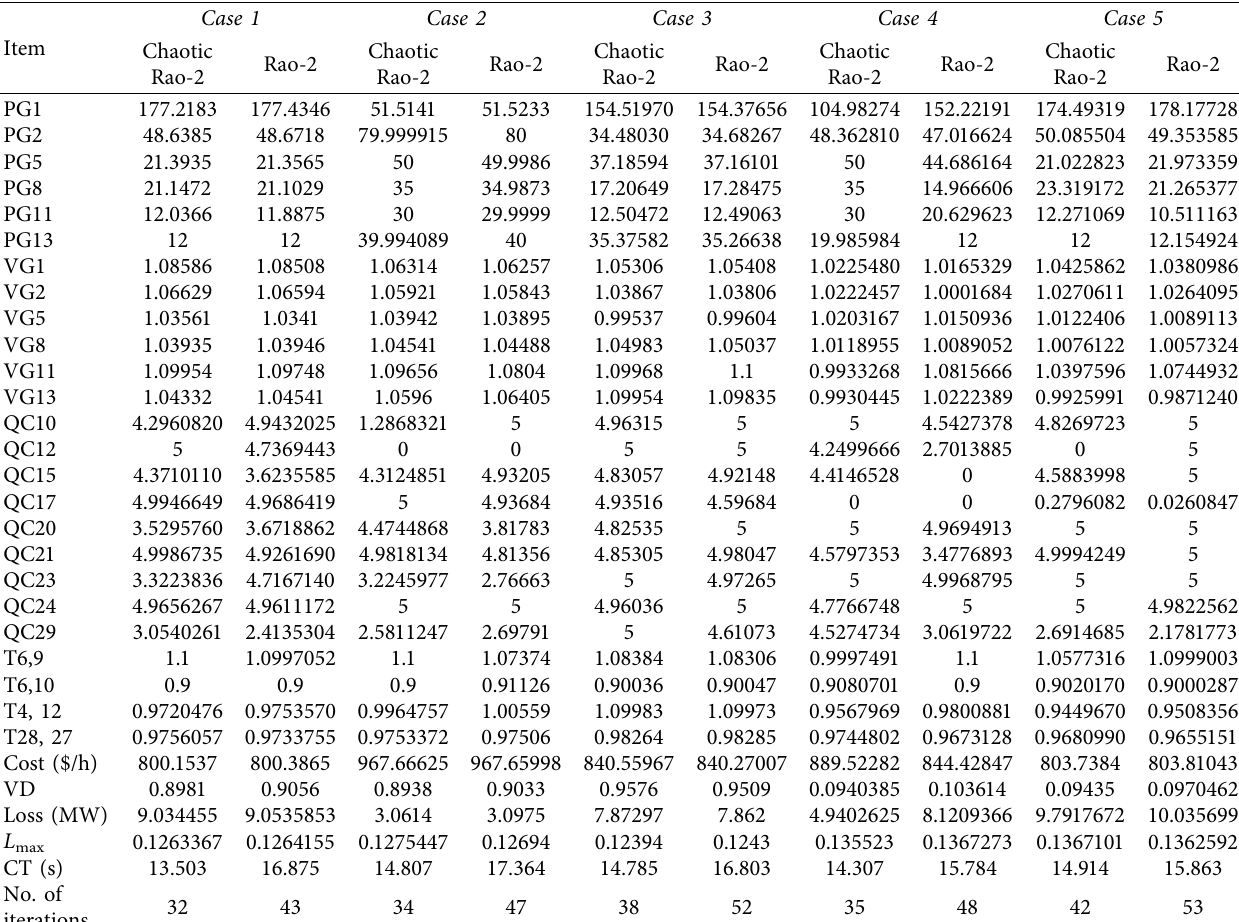
Table 1: Simulation results for the OPF problem obtained from 100 runs for cases 1–5 using the basic Rao-2 and the chaotic Rao-2